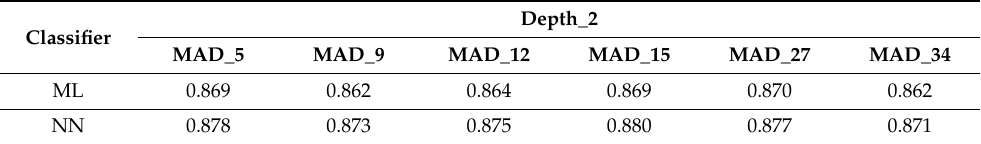
Table 19. Total probabilities of correct classification for depth 2 and different MAD for the image in Figure 20b using ML and NN classifiers.